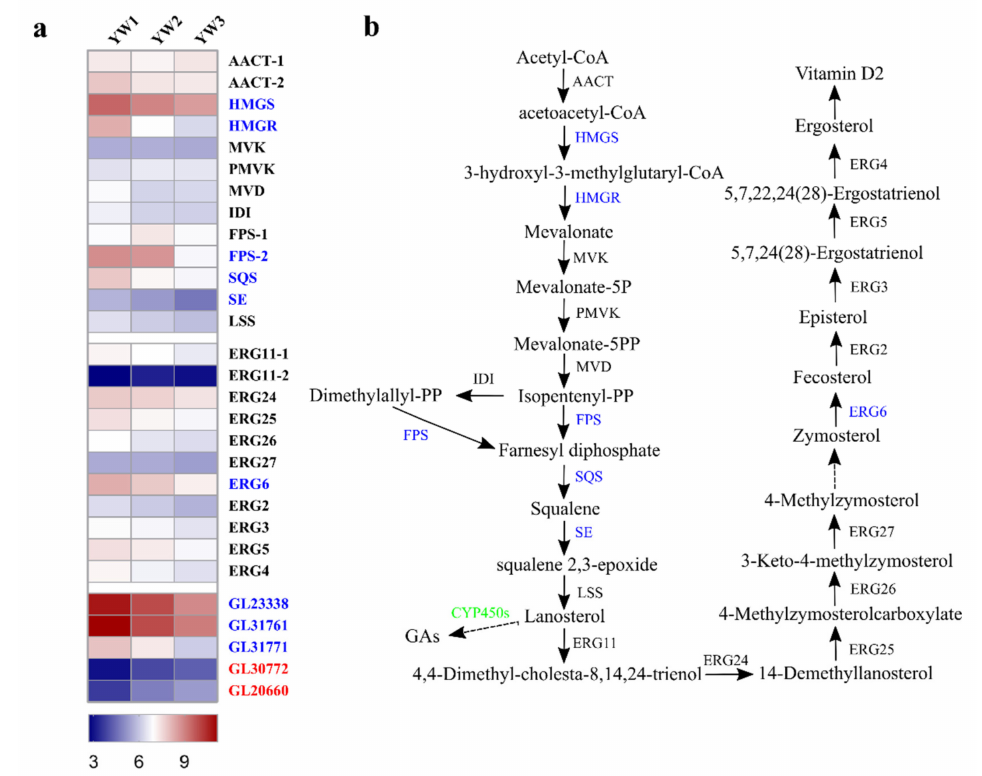
Figure 4. DEGs predictably involved in triterpenoid and ergosterol biosynthesis pathways. ( a ) Heatmap shows the expression level of the genes coding for key enzymes, which are predictably involved in triterpenoid and ergosterol biosynthesis pathways. The square represents the log 2 ratio of the expression level in different developmental stages. Red, upregulated; blue, downregulated. ( b ) A schematic of triterpenoid and ergosterol biosynthesis pathways in Ganoderma lucidum